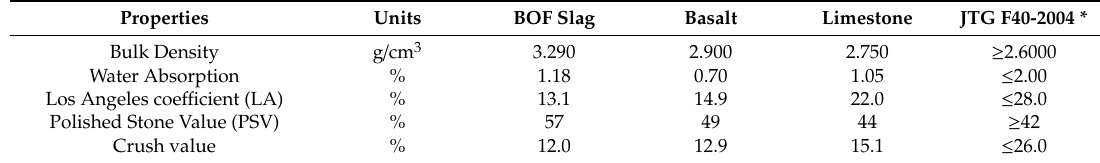
Table 4. Technical indicators of BOF slag and natural aggregates [30].